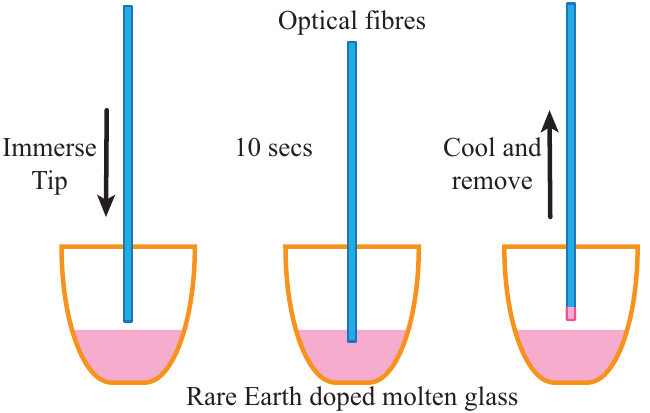
Figure 1. Fibre coating method, in which the fibre tip is briefly immersed within the molten glass to form a thin layer of active temperature-sensitive tellurite glass on the end face of the silica